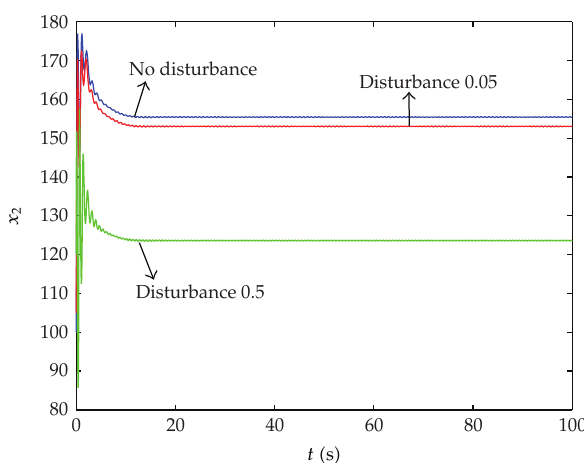
Figure 9: Trajectories of the state variable x 2 by T1ABFC with external disturbances.